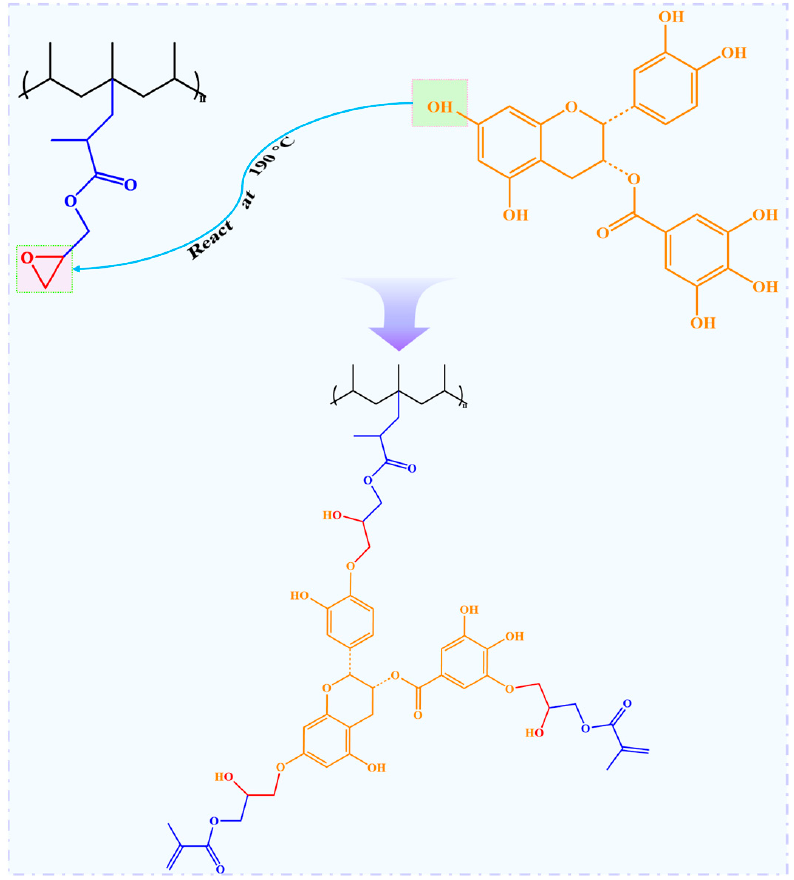
Figure 9. Schematic illustration of the graft reaction of tea polyphenols (C) and GMA onto polypropylene.